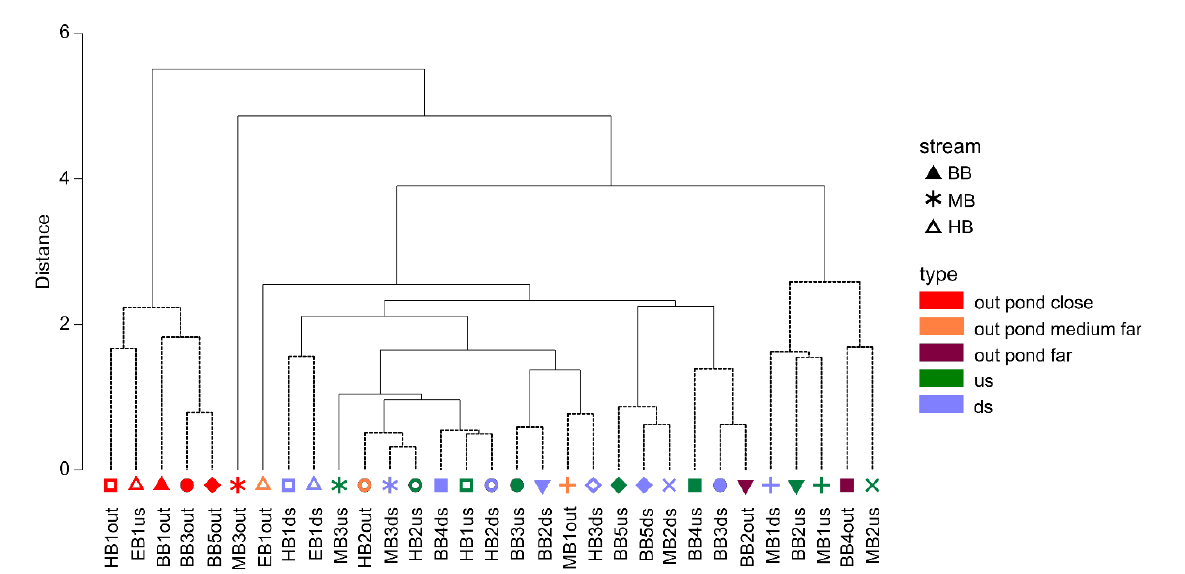
Figure 3. Result of the cluster analysis based on average normalized values for all temperature metrics in summer for monitoring points in pond outlet channels close to the pond (red), medium (orange) and far from the pond (violet), and monitoring points upstream (green) and downstream (blue) of the pond outlet channels into the main streams; similar symbols represent monitoring points at the same sampling site; filled symbols represent sites in BB, cross/star symbols represent sites in MB; open symbols represent sites in HB; solid lines represent a significant separation of the two branches, dashed lines represent that the separation is not significant, according to SIMPROF test.